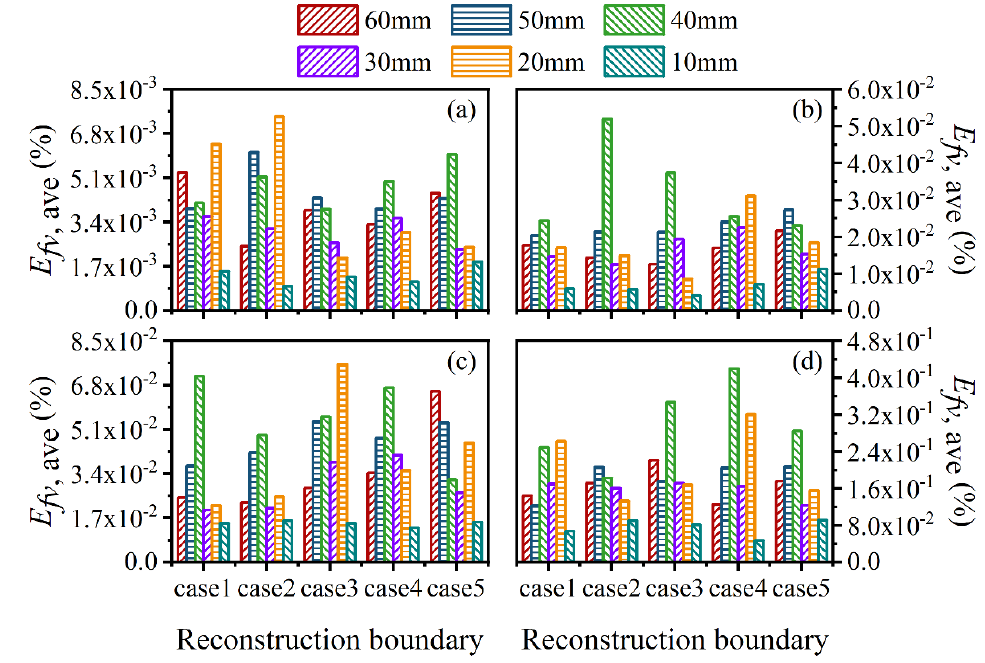
Figure 24. The average relative reconstruction error for soot volume fraction with different SNR considering different reconstruction boundaries. ( a ) SNR = 80 dB; ( b ) SNR = 65 dB; ( c ) SNR = 60 dB; ( d ) SNR = 46 dB.